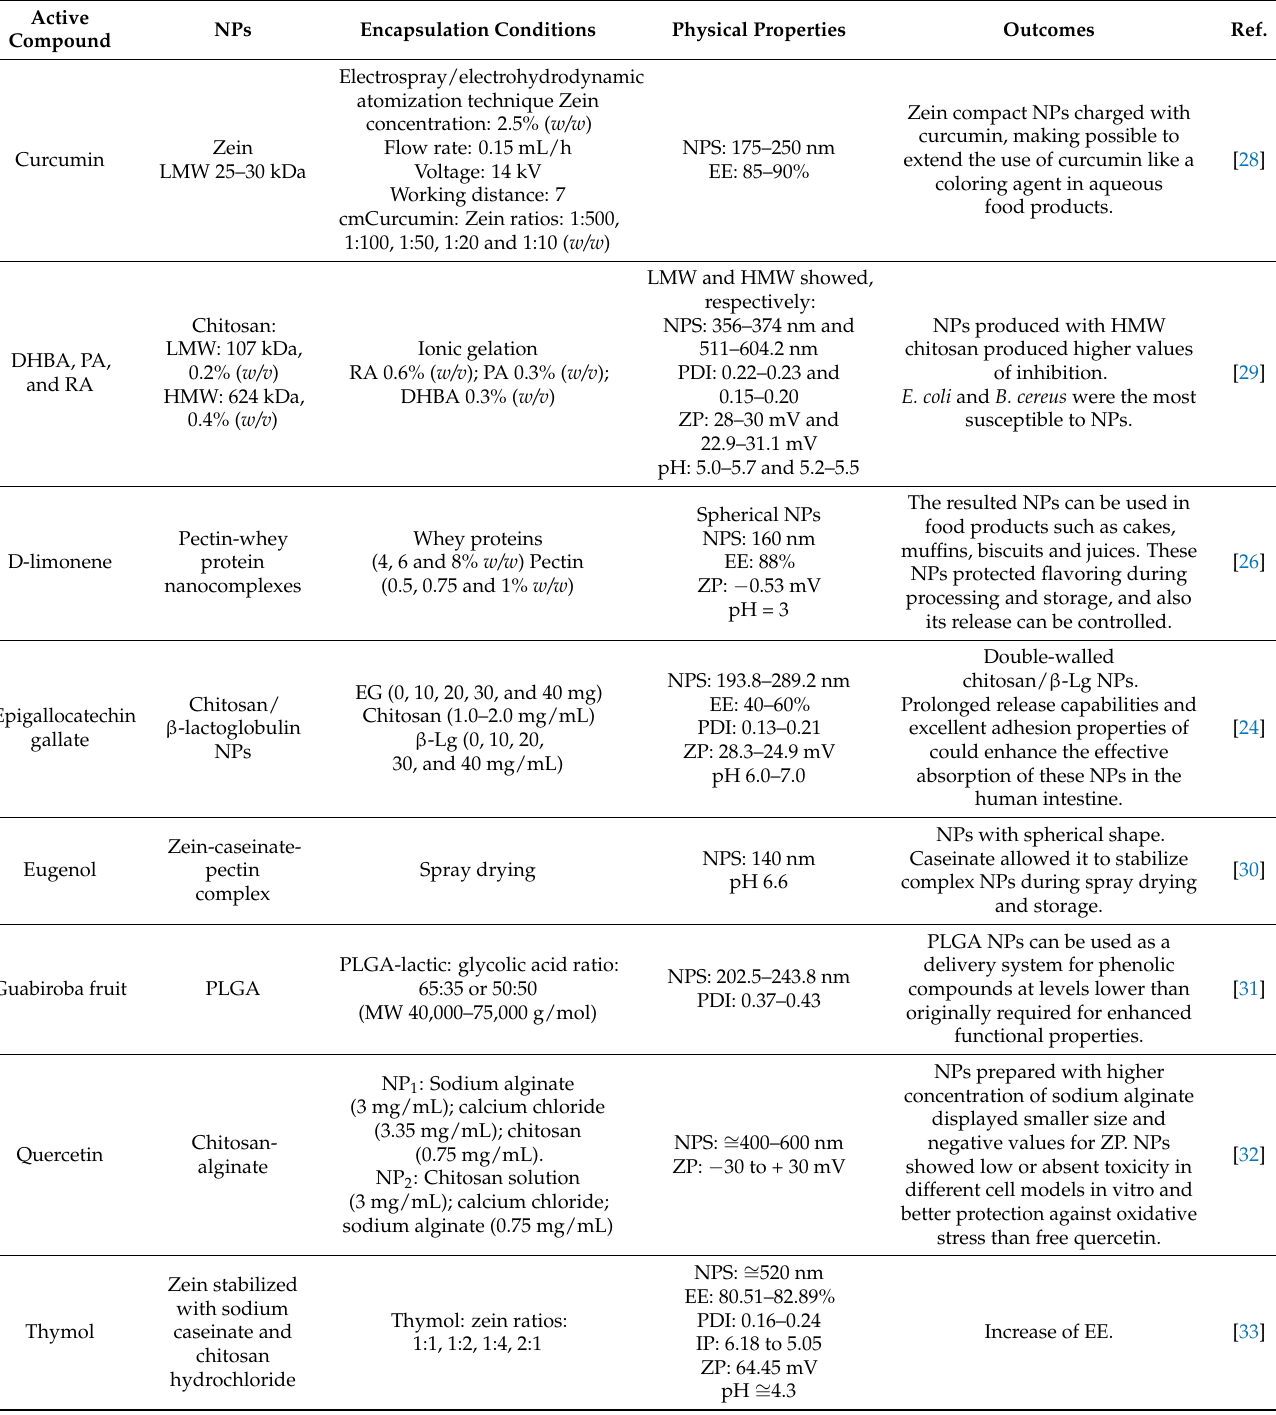
Table 3. Effect of NPs characteristics on their stability and potential applications in the food sector. Active